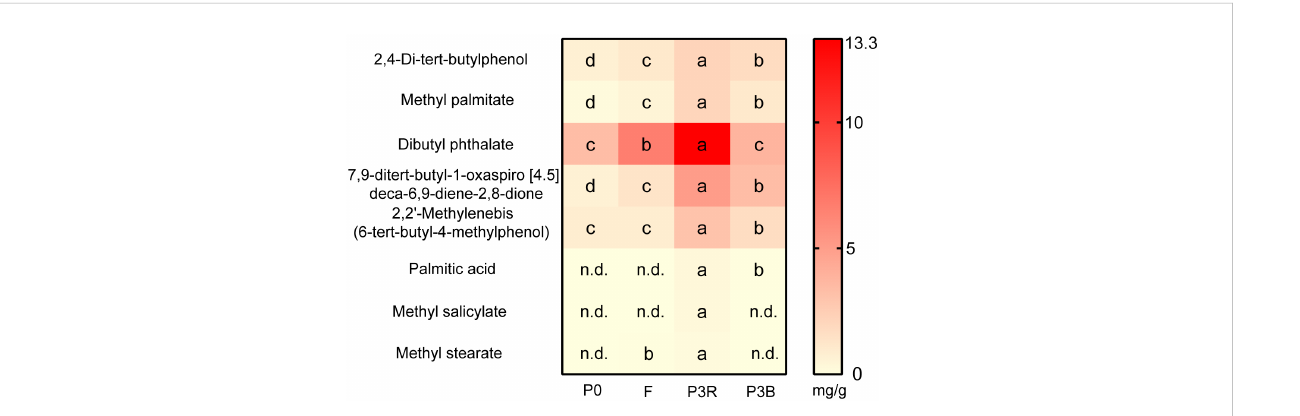
FIGURE 1 Relative concentrations of eight toxic compounds in the soil. Values represent means ± SD (n = 3). Different letters indicate signi fi cant differences according to LSD test (p < 0.05), n.d., not detected. P0, control soil; F, one-year fallow soil; P3R, Rhizosphere soil after three years consecutive monoculture; P3B, Bulk soil after three years consecutive